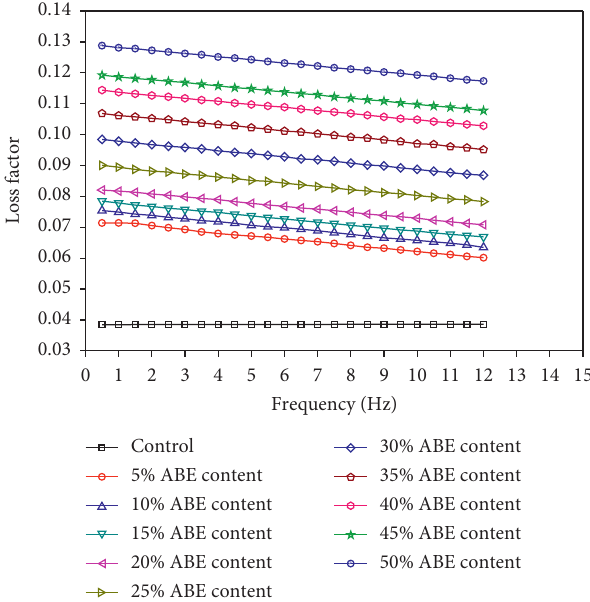
Figure 9: Influences of ABE content on the viscoelastic